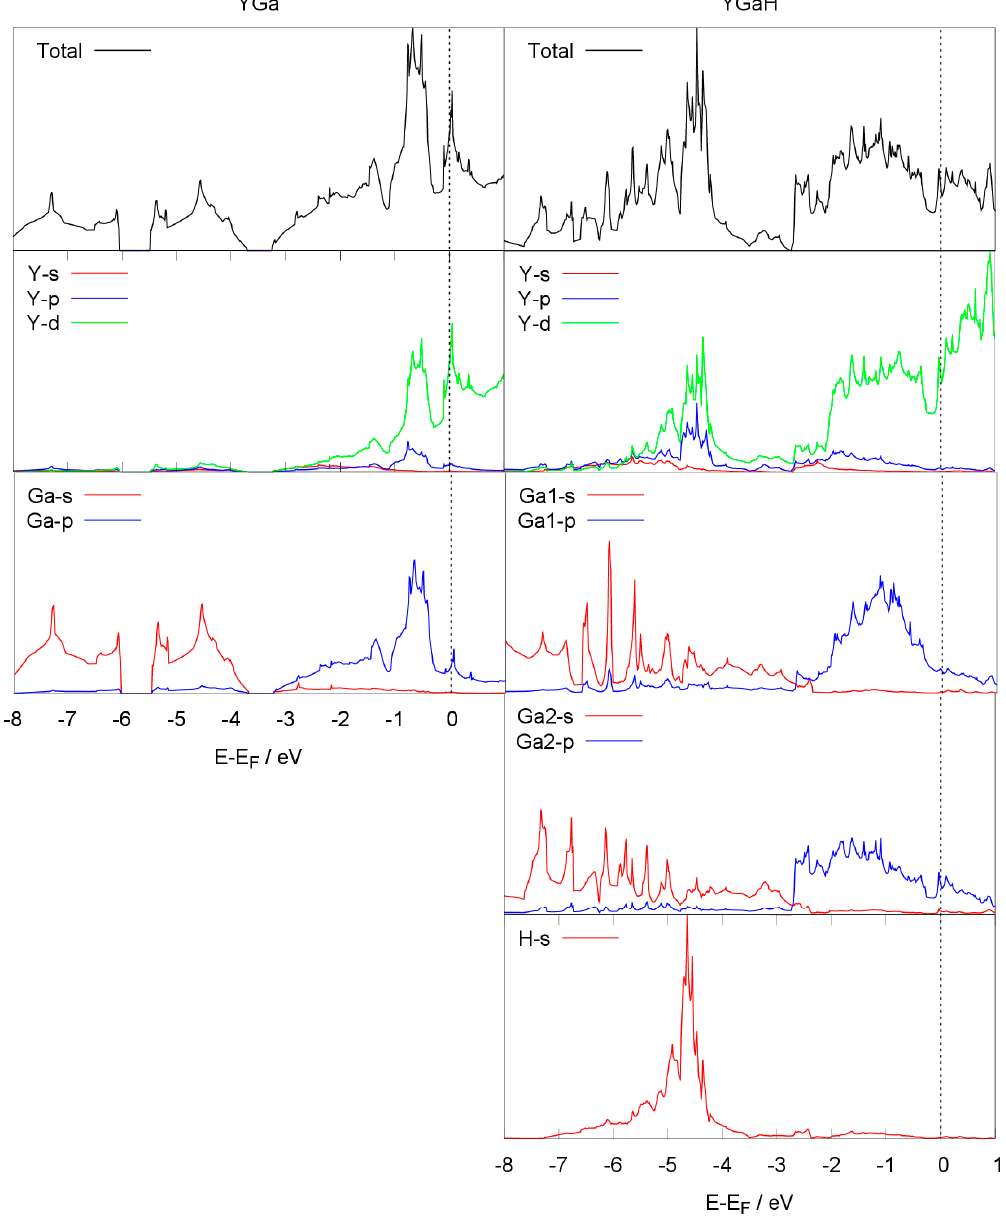
Figure 7. Calculated density of states of YGa ( left ) and YGaH ( right ) with black dotted lines indicating the Fermi level.